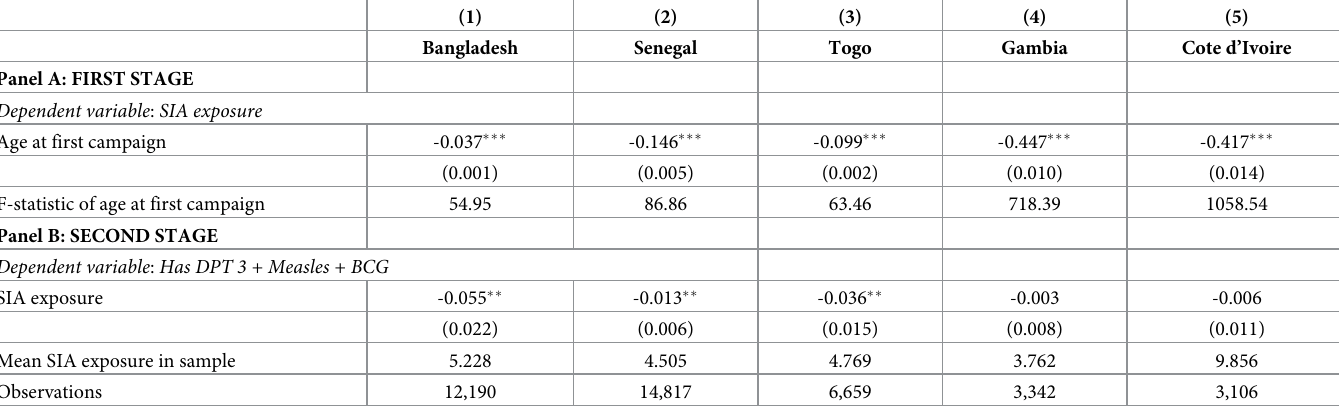
Table 2. Impact of supplementary immunization activities (SIAs) on routine vaccinations—instrumental variable (IV)